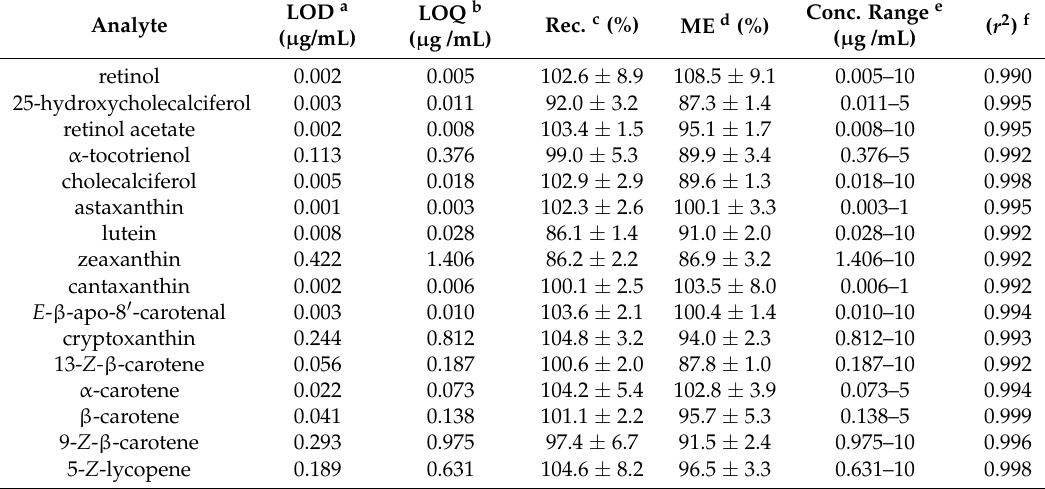
Table 3. Limit of detection (LOD), limit of quantification (LOQ), recovery, matrix effect, linearity range and correlation coefficient obtained in samples by the HPLC-MS/MS